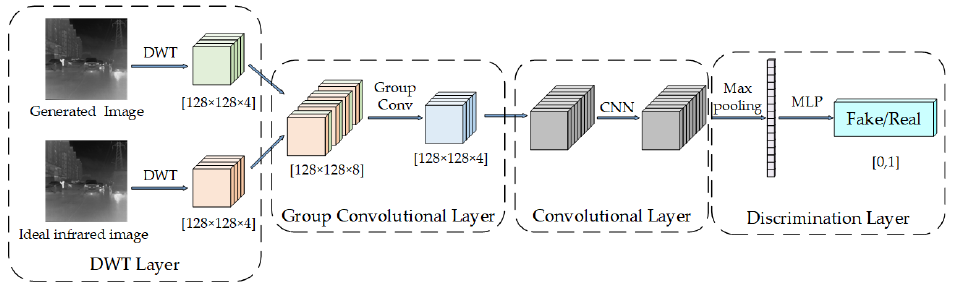
Figure 10. Structure of the